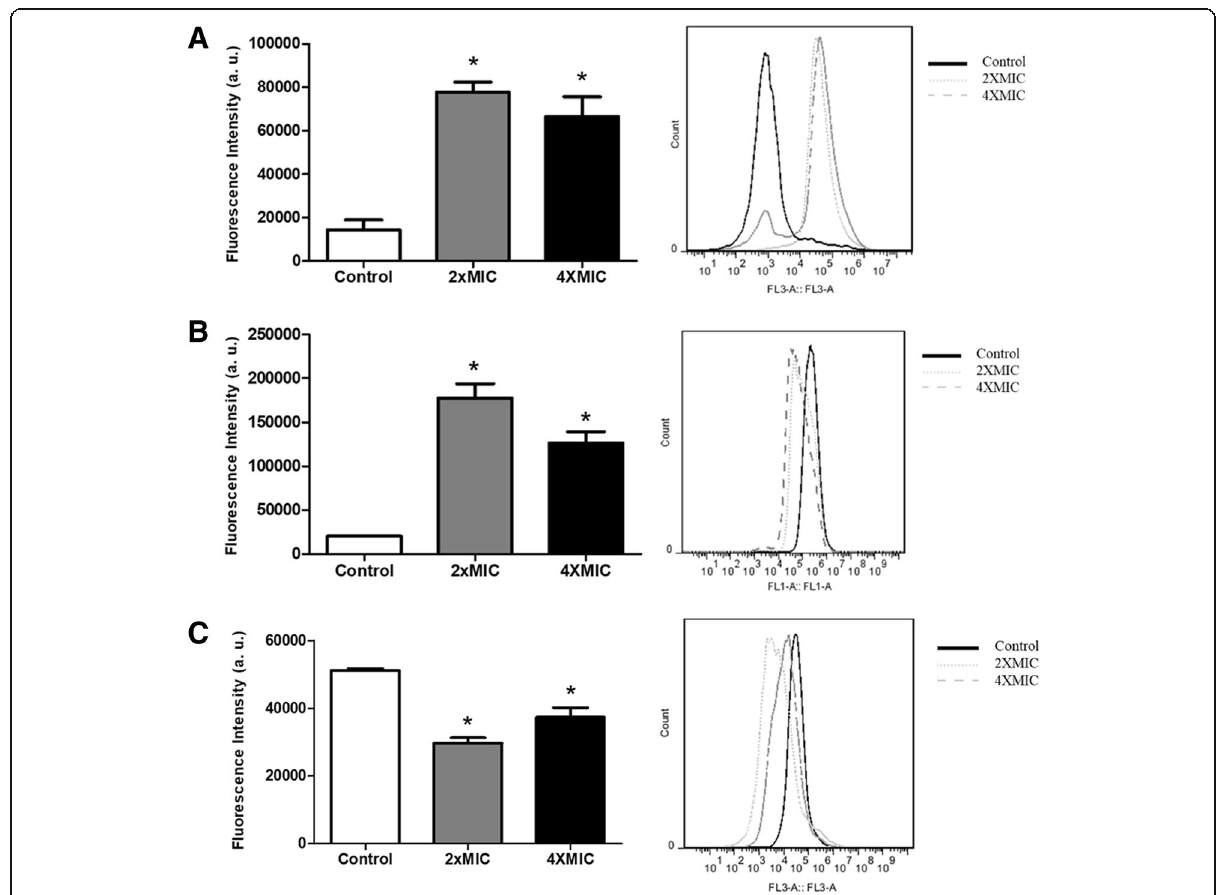
Fig. 3 Investigation of antifungal mechanisms of hexane extract from Spondias tuberosa leaf against Candida glabrata . It was evaluated the effects of extract treatment on the production of mitochondrial superoxide anion ( a ), mitochondrial membrane potential ( b ) lysosomal membrane stability ( c ). (*) Significant differences compared with untreated cells (control). Minimal inhibitory concentration (MIC 50 ) was 0.078